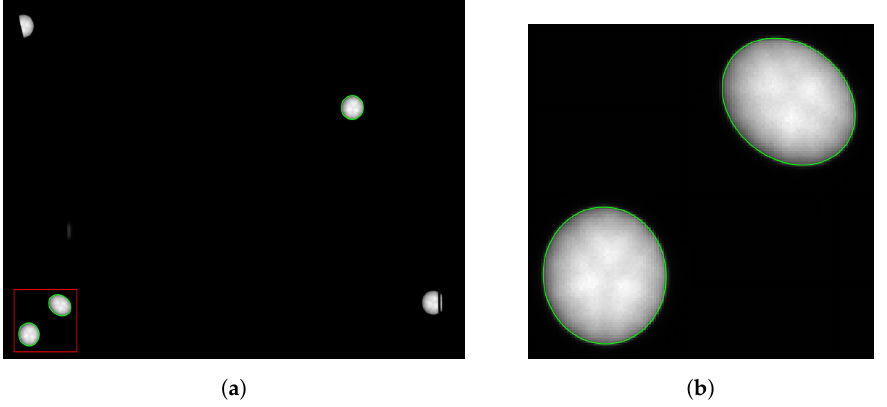
Figure 3. Result of object points segmented by ellipses (green) in the image ( a ). Non-unique and interrupted object points are automatically eliminated. ( b ) A detailed